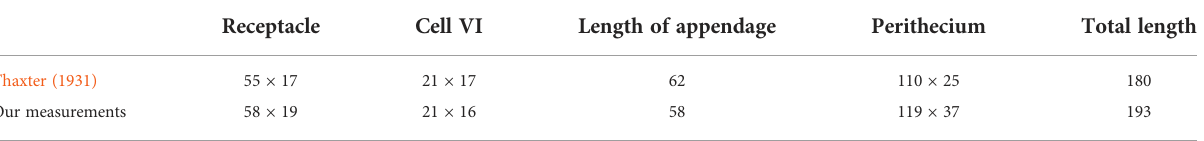
Cell VI Length of appendage